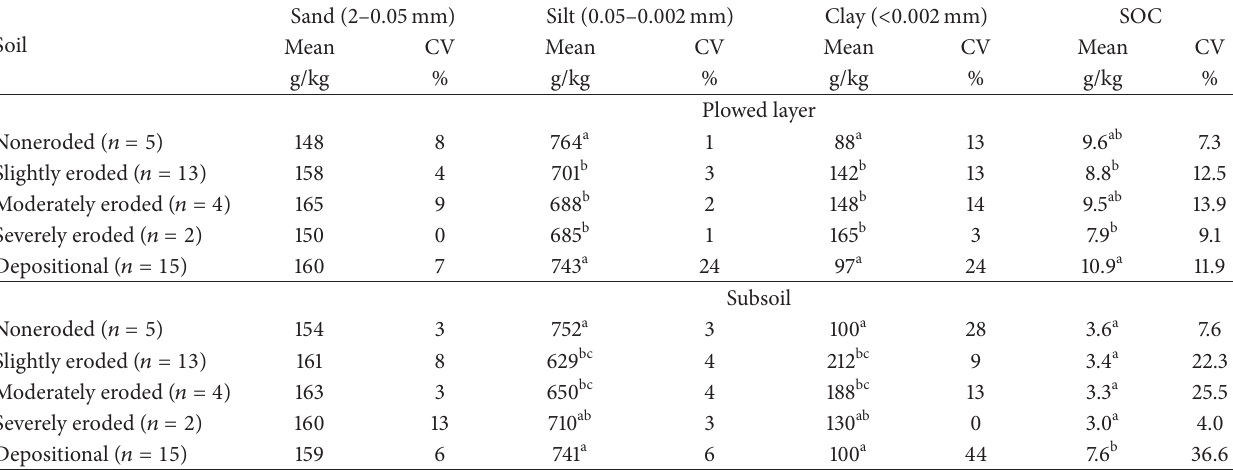
Table 3: Soil particle fractions and SOC concentration in the plowed layer and subsoil of the studied soils and results of ANOVA; means were separated by Tukey’s HSD test.